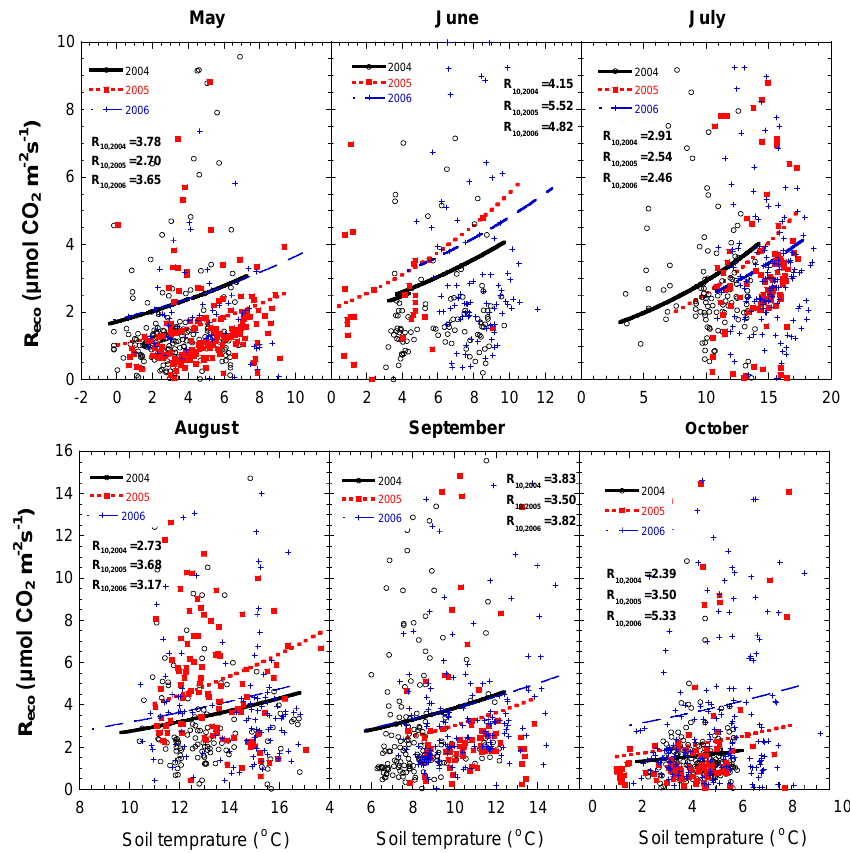
Fig. 2. Response of ecosystem respiration ( R eco ) to change in soil temperature at the depth of 5cm during growing season. Data were half-hourly under high turbulence conditions ( u ∗ > 0 . 1ms − 1 ) from 2004 to 2006.